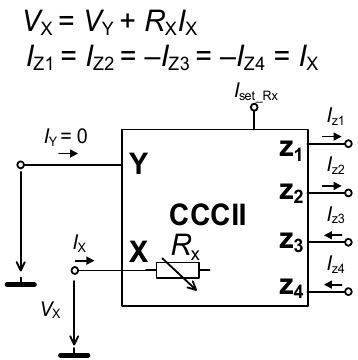
Figure 4. Schematic symbol and description of the ideal interterminal transfer relations of the current-controlled current conveyor of the second generation (CCCII). current-controlled current conveyor of the second generation (CCCII).